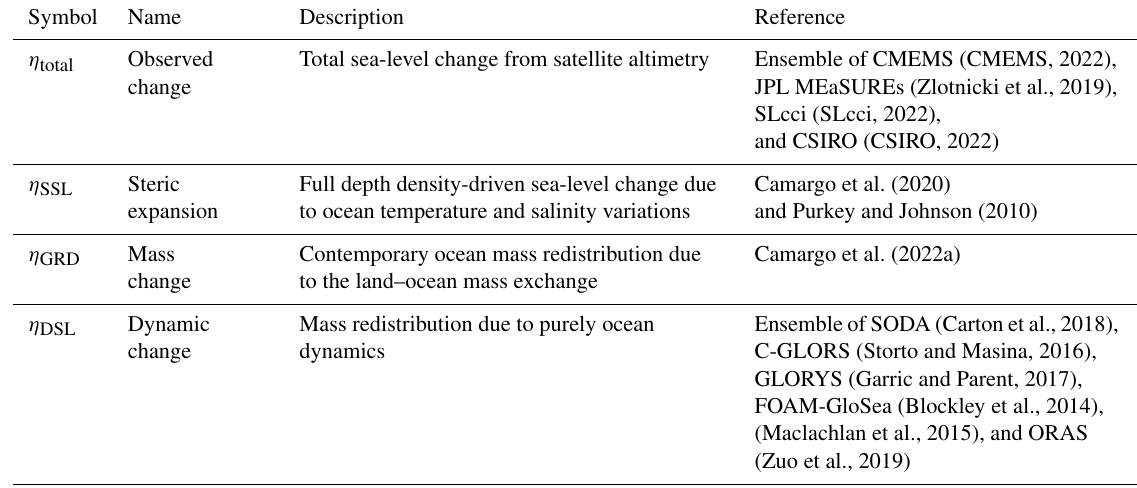
Table 1. Summary of the sea-level budget components and data sources used in this paper.